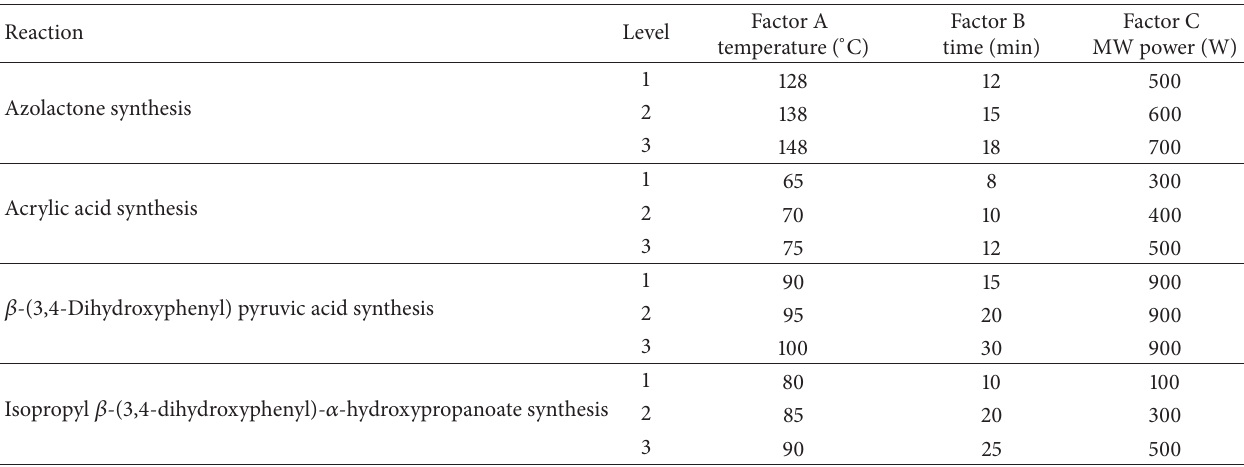
Table 1: Experimental factors and